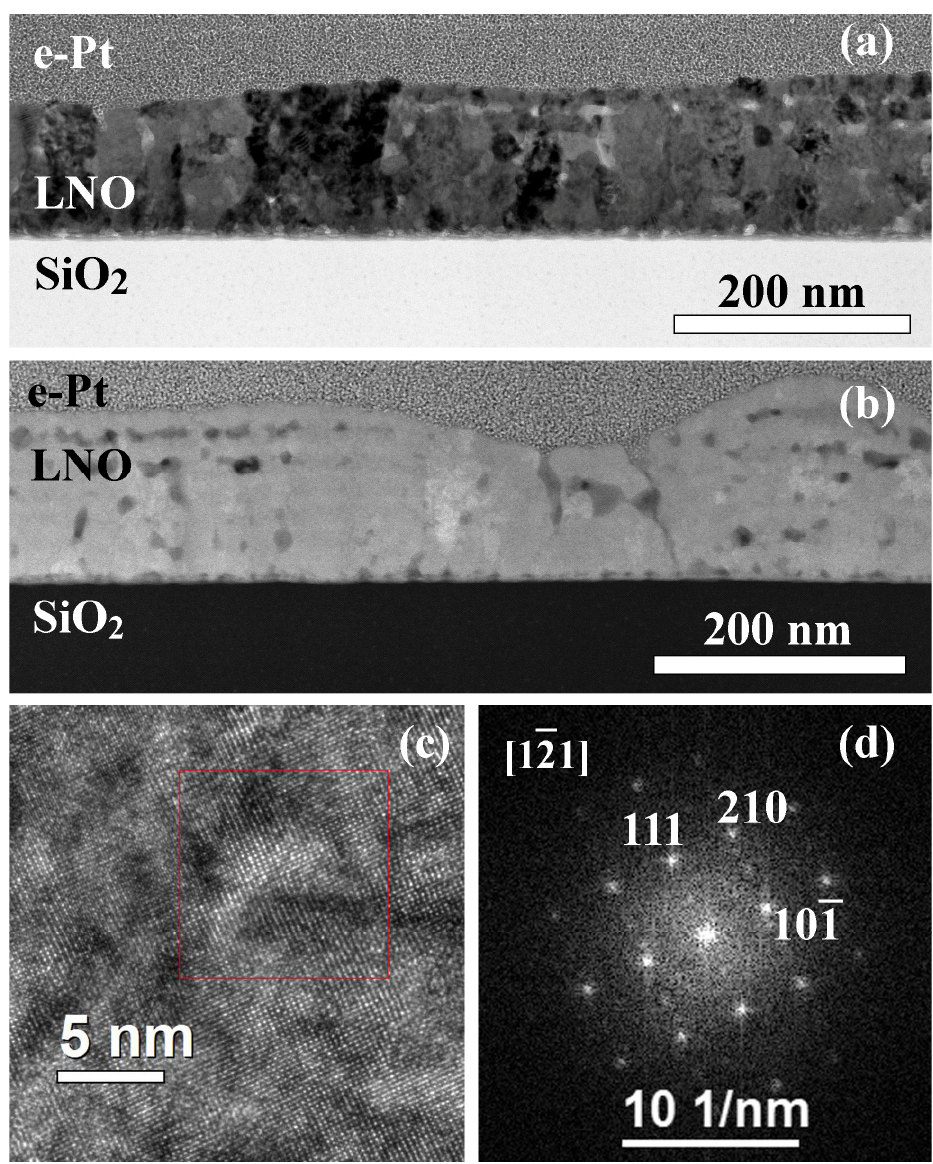
Figure 5. Structure of a LNO-cryst-5 min sample: BF TEM image ( a ), HAADF STEM image ( b ), HRTEM image ( c ), and the corresponding Fourier diffractogram ( d ).